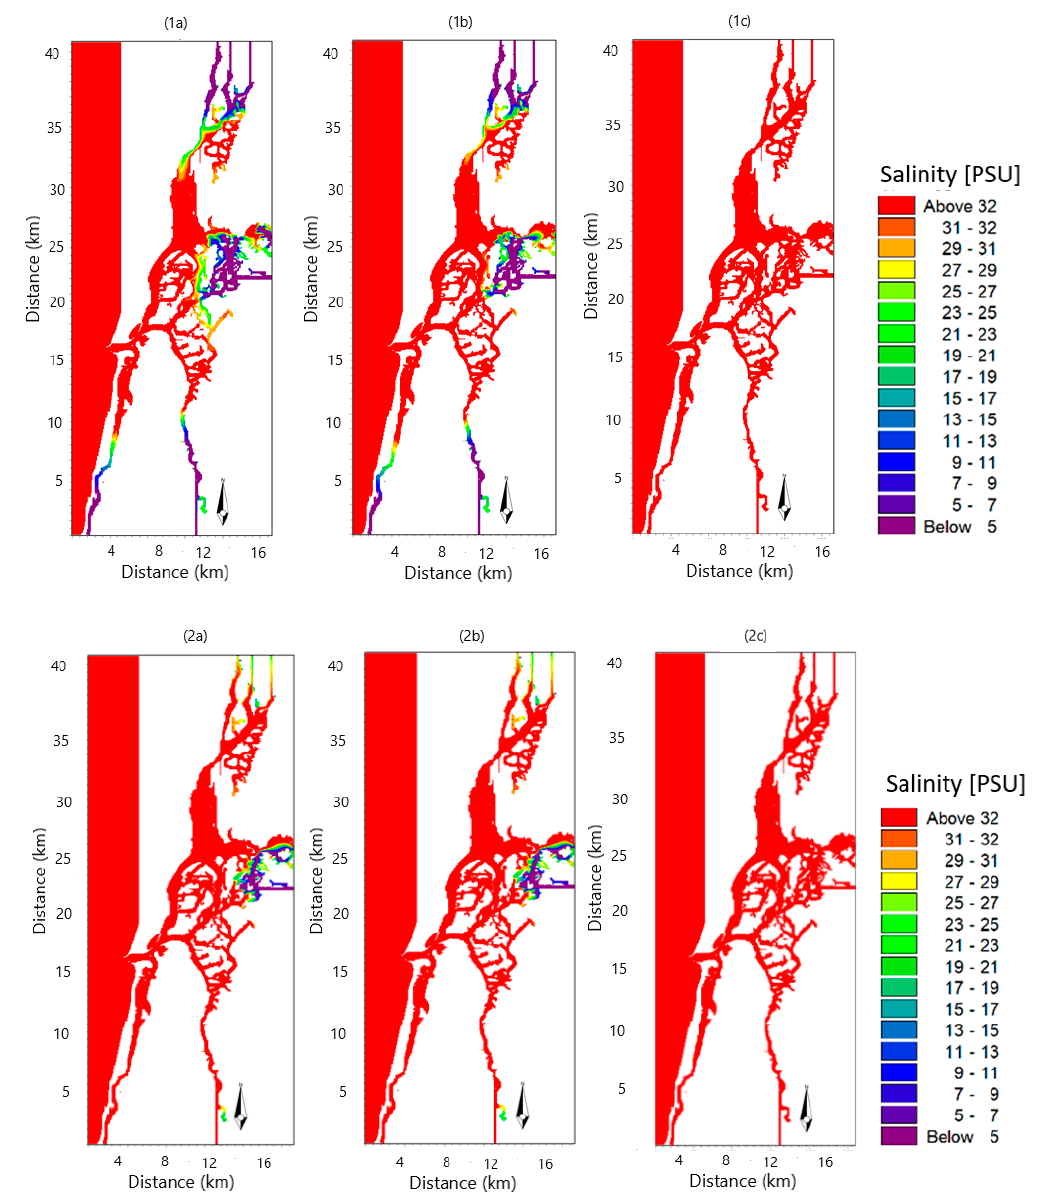
Figure 5. Snapshots of the surface salinity (PSU) for BS ( a ), SC1 ( b ), and SC2 ( c ), for two instants: 1— high tide, flooding at the lagoon mouth and ebbing at the mouth of the rivers (17 / 9 / 2000); 2—high tide, ebbing at the lagoon mouth and flooding at the mouth of the rivers (27 / 9 / 2000).